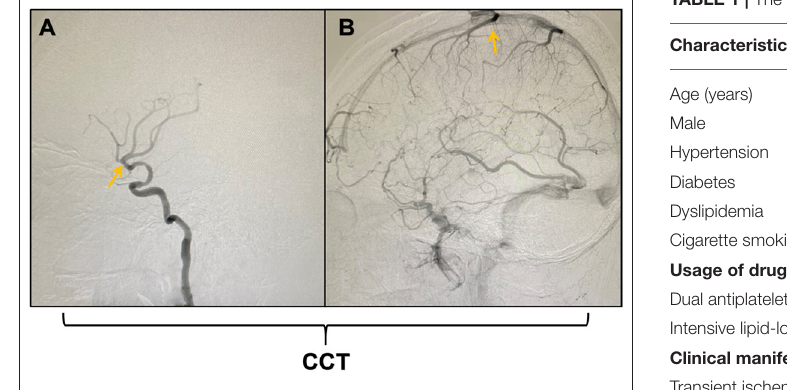
TABLE 1 | The demographic and clinical data for patients with and without DICE. Characteristics